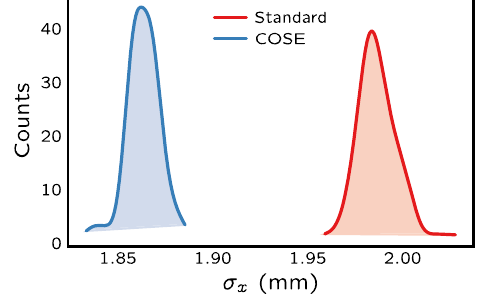
FIG. 10. Comparison of distribution of measured beam size in the transfer line to the North Area targets for tune sweep (standard) slow extraction and COSE at grid BSGH.210350.